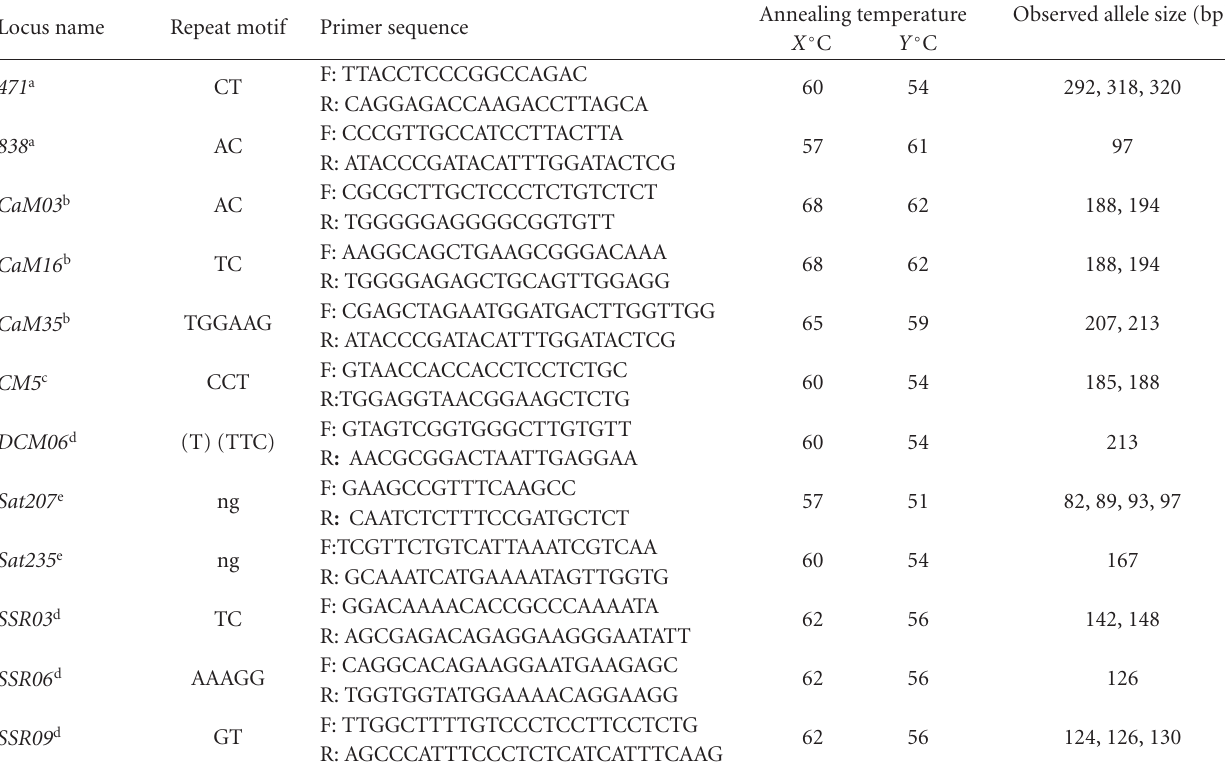
Table 2: List of primer-pairs used to amplify the SSR loci used in this study and their annealing temperature: the repeat motifs of the loci and observed fragment sizes of the alleles.